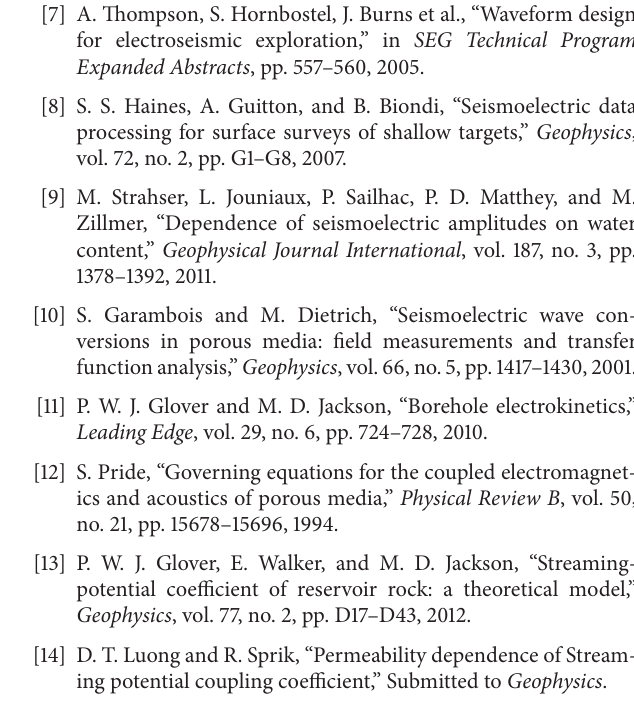
Ellermeijer for his assistance in building up the experimental